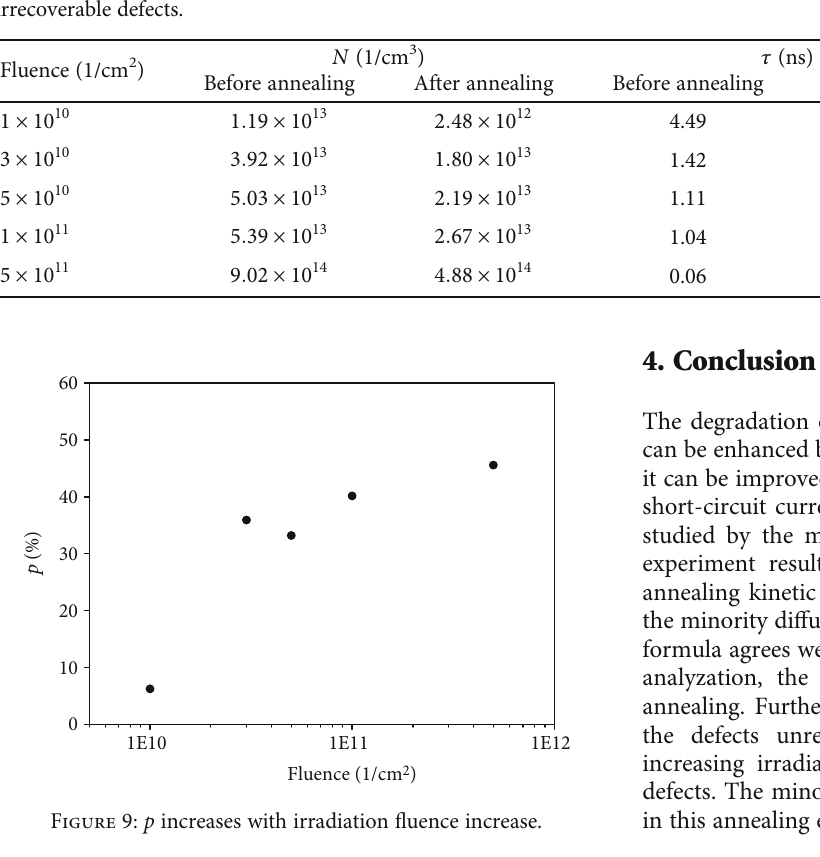
during annealing and corresponding fi tting results. SC